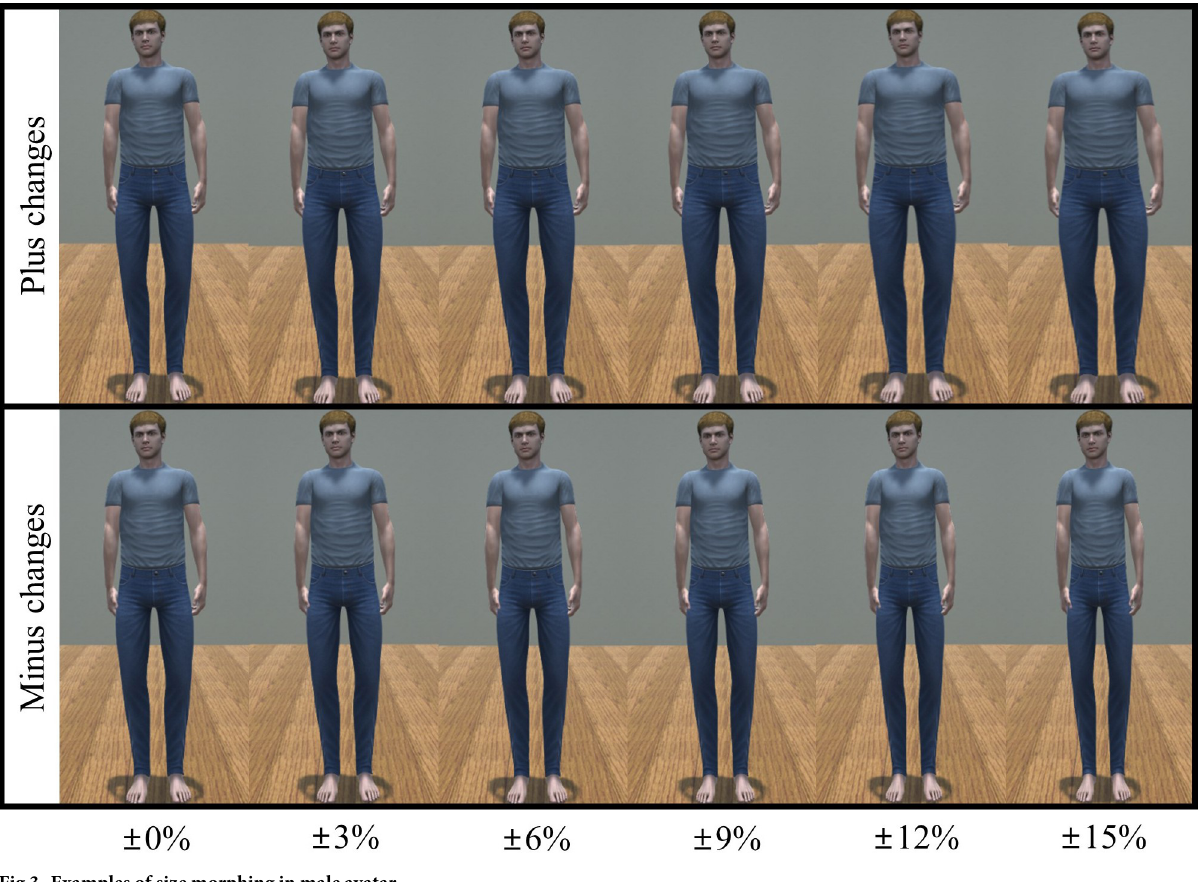
Fig 3. Examples of size morphing in male